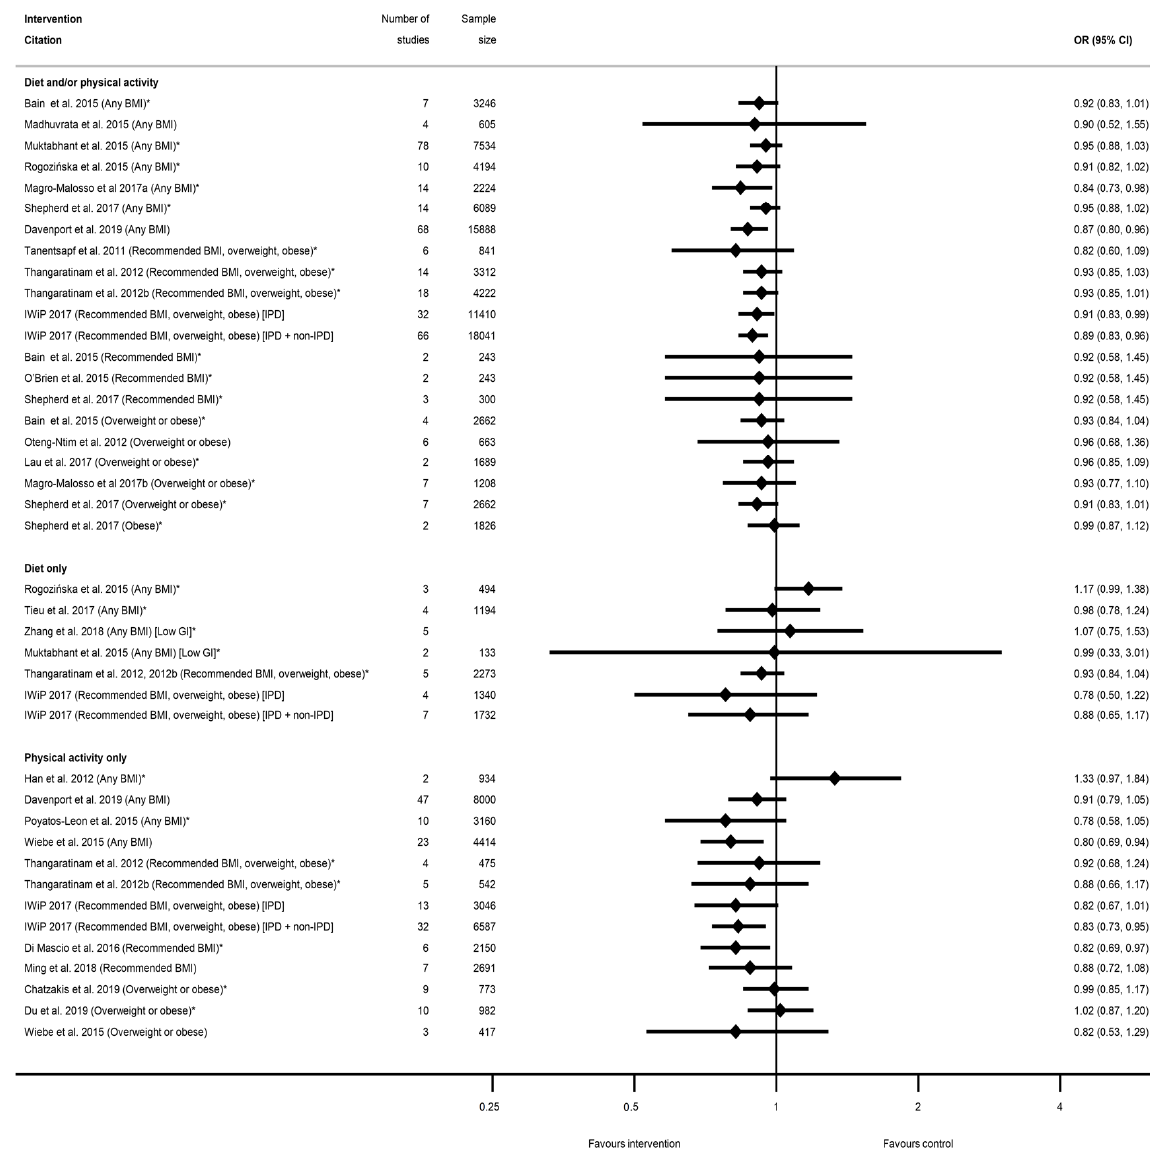
Figure 8. Forest plot of meta-analysis results for caesarean delivery. * indicates the estimate is relative